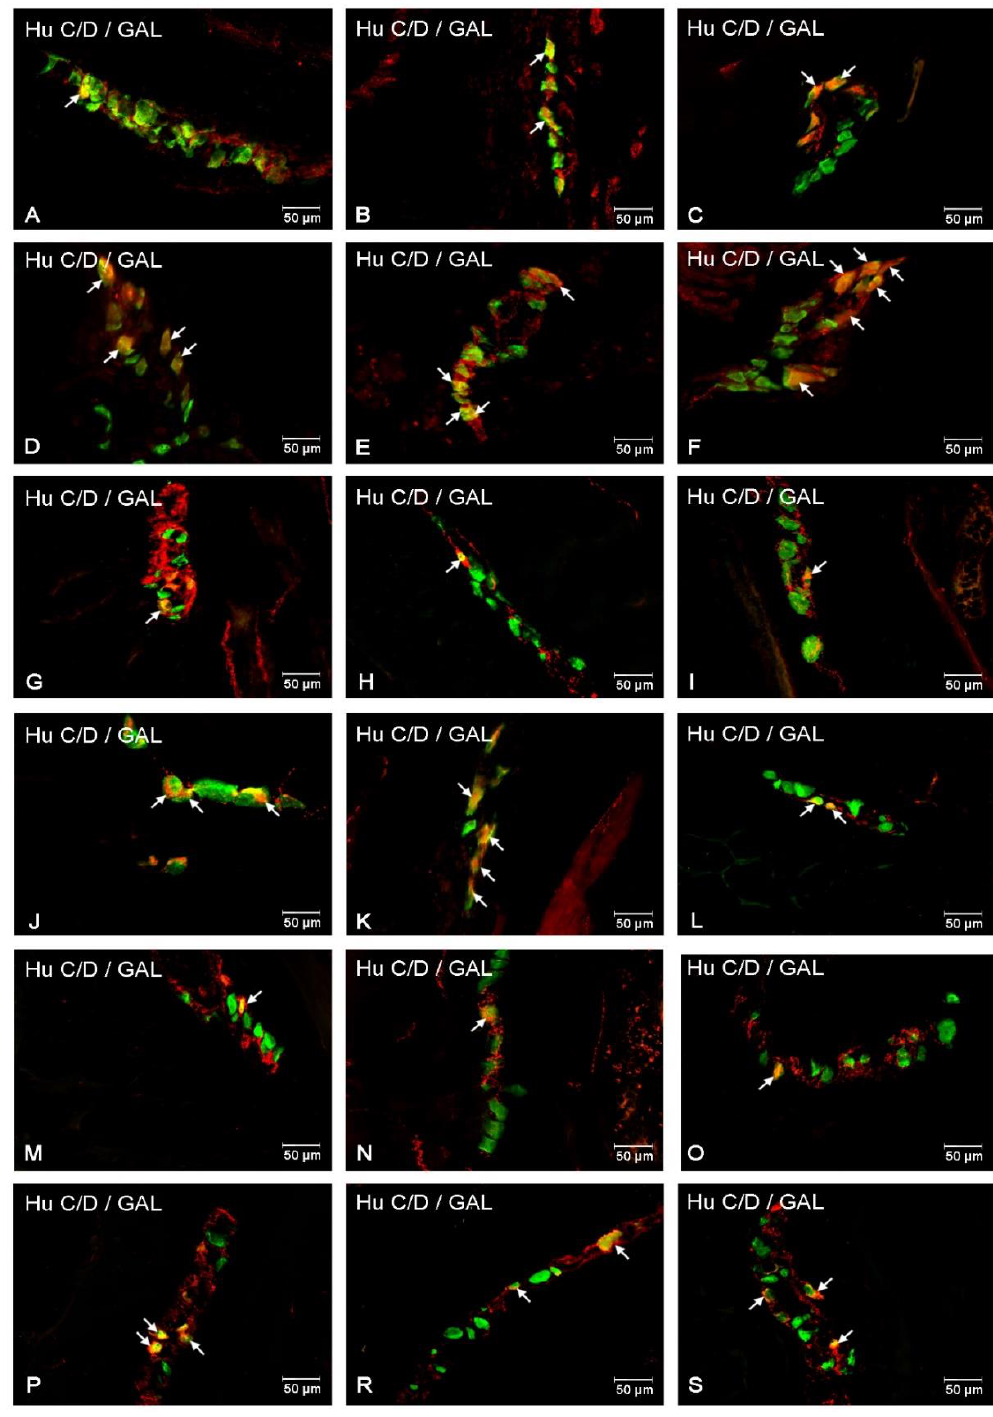
Figure 4. Immunofluorescent staining presenting GAL immunoreactivity in cell bodies in the particular intramural plexuses in the small intestine in both control and experimental groups. All photographs have been created by the digital superimposition of two color channels; Hu C/D-positive—used here as a pan-neuronal marker (green), and GAL-positive (red). The arrow shows perikaryon containing both examined substances. Myenteric plexus of the duodenum ( A,D ), jejunum ( B,E ), and ileum ( C,F ) under physiological condition ( A–C ) and after streptozotocin administration ( D–F ).Outer submucosal plexus of the duodenum ( G,J ), jejunum ( H,K ), and ileum ( I,L ) under physiological condition ( G–I ) and after streptozotocin administration ( J–L ). Inner submucosal plexus of the duodenum ( M,P ), jejunum ( N,R ), and ileum ( O,S ) under physiological condition ( M–O ) and after streptozotocin administration ( P–S ).